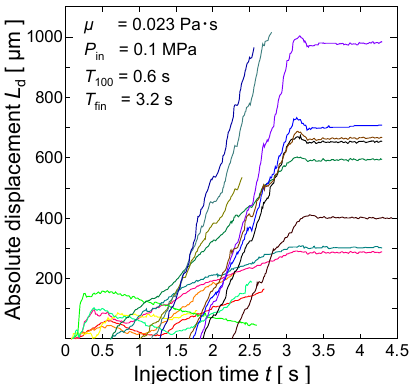
Figure 16. Time evolution of L d with injection pressure of P in = 0.1 Pa.